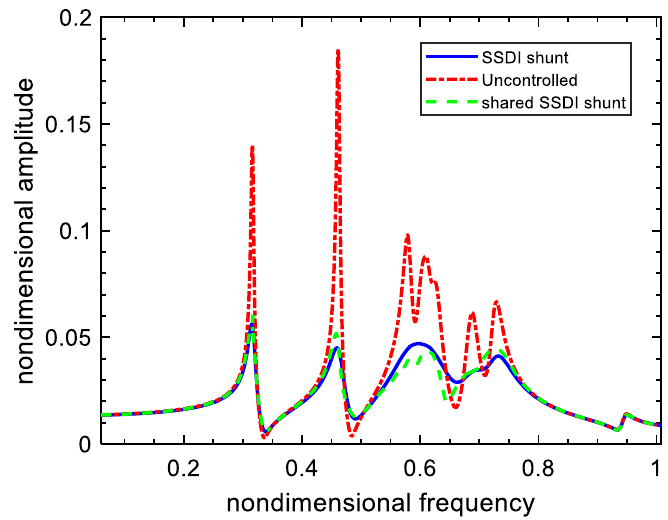
Figure 22. Forced response of the most dangerous blades under multi-engine-order excitation (E = 0, 1, 2 at the same time).